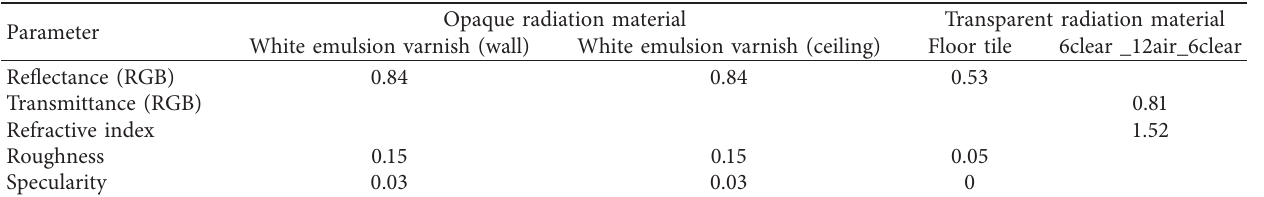
Table 5: Material information of radiation from opaque radiation material and glass.